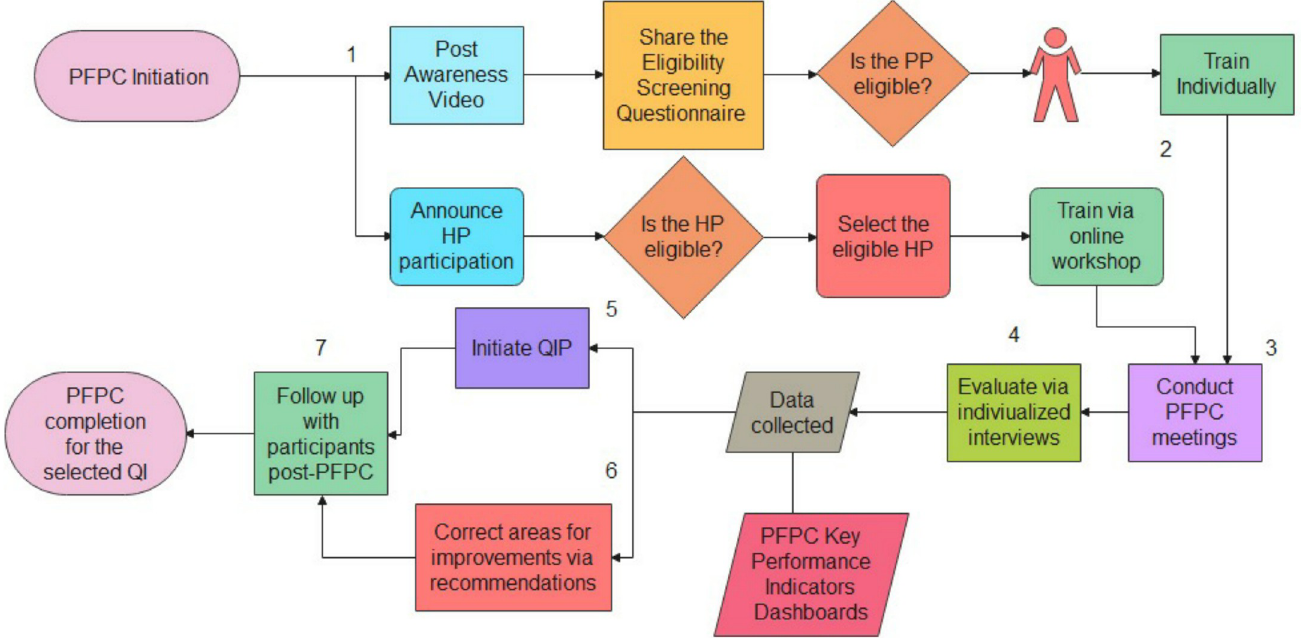
Fig 1. Flowchart of the patient and family partnership committee process. (1) PFPC is initiated by posting a video online to increase the awareness of patients on patient partnership. The opportunity for participation in the PFPC is announced for HP at the healthcare setting. (2) After recruiting eligible participants, patient partners are trained individually by the PFPC coordinator. Healthcare professionals are also trained prior to the meetings. (3) The PFPC meetings are conducted directly or online, and (4) participants are evaluated by individualized interviews. (5) After data collection, the quality improvement process can be initiated. (6) Moreover, the suggested opportunities for improvement can be addressed. (7) Participants are followed-up post-PFPC. https://doi.org/10.1371/journal.pone.0270654.g001 PLOS ONE | https://doi.org/10.1371/journal.pone.0270654 July 7,